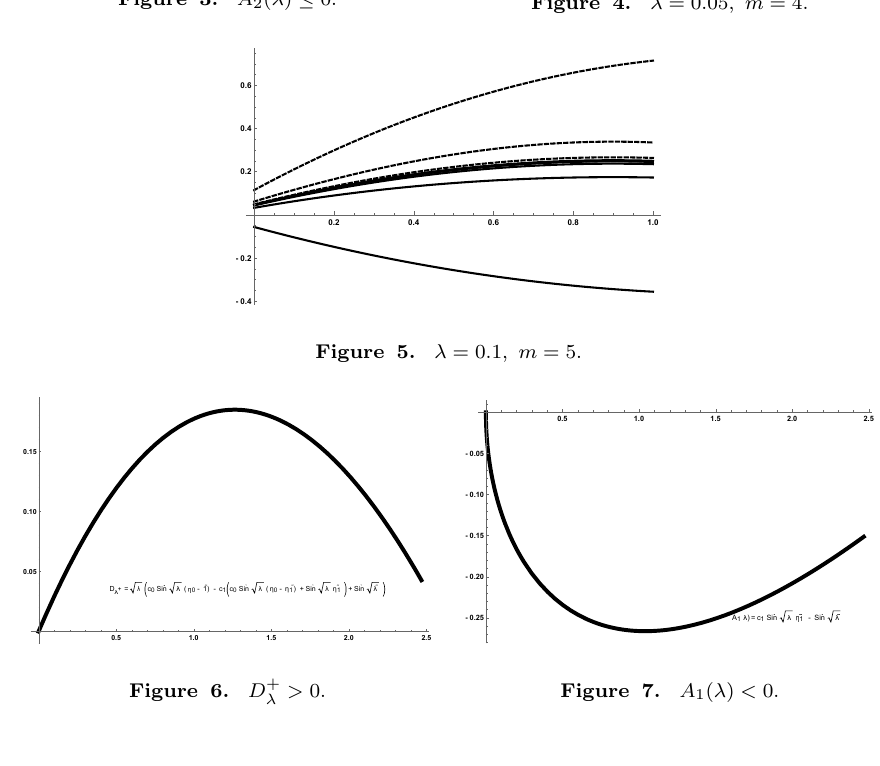
Figure 3. A 2 ( λ ) ≤ 0 . Figure 4. λ = 0 . 05 , m = 4 .